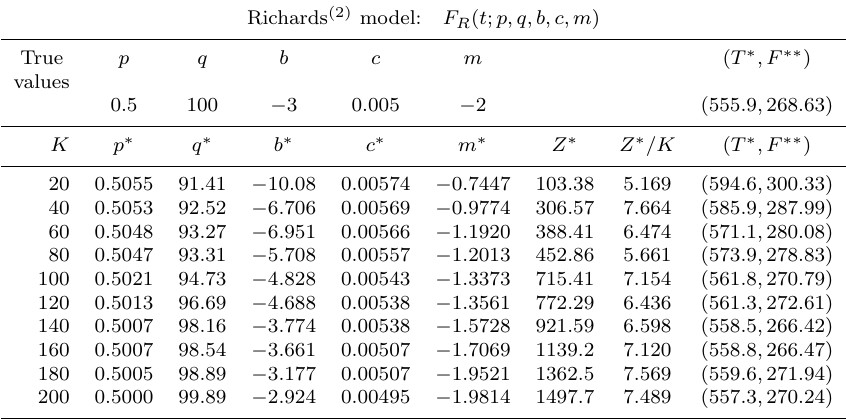
Table 5. Richards (2) model ( T = 4000): Optimal parameters, optimal value and an approximation of the inflection point ( T ∗∗ ,F ∗∗ ) for different data sets with an increasing degree of